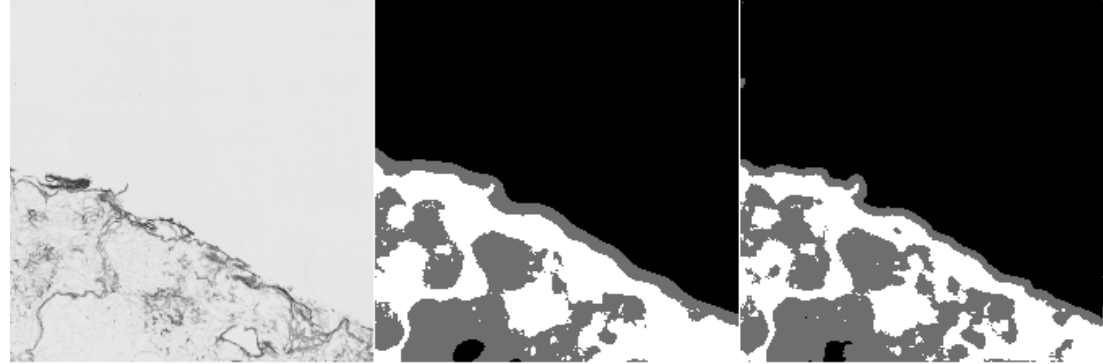
Figure 9. Example of semantic segmentation, where the neural network reached comparable results. The original image (on the left ), the result from the HCTFS (in the middle ), and the results from the neural network (on the right